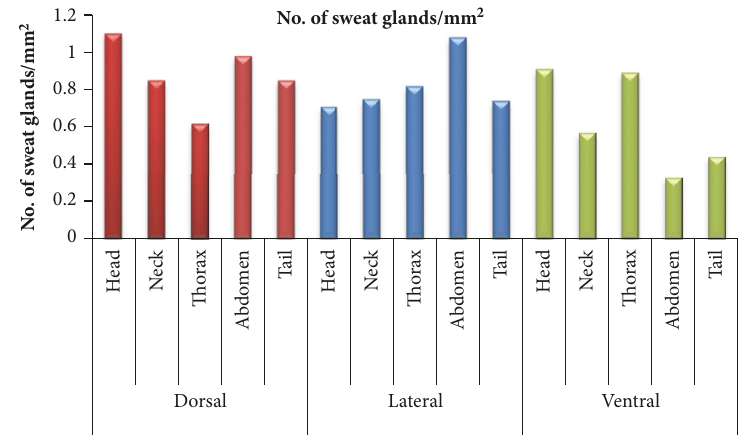
Figure 2: Graph showing distribution of no. of sweat glands/mm 2 in different body regions.